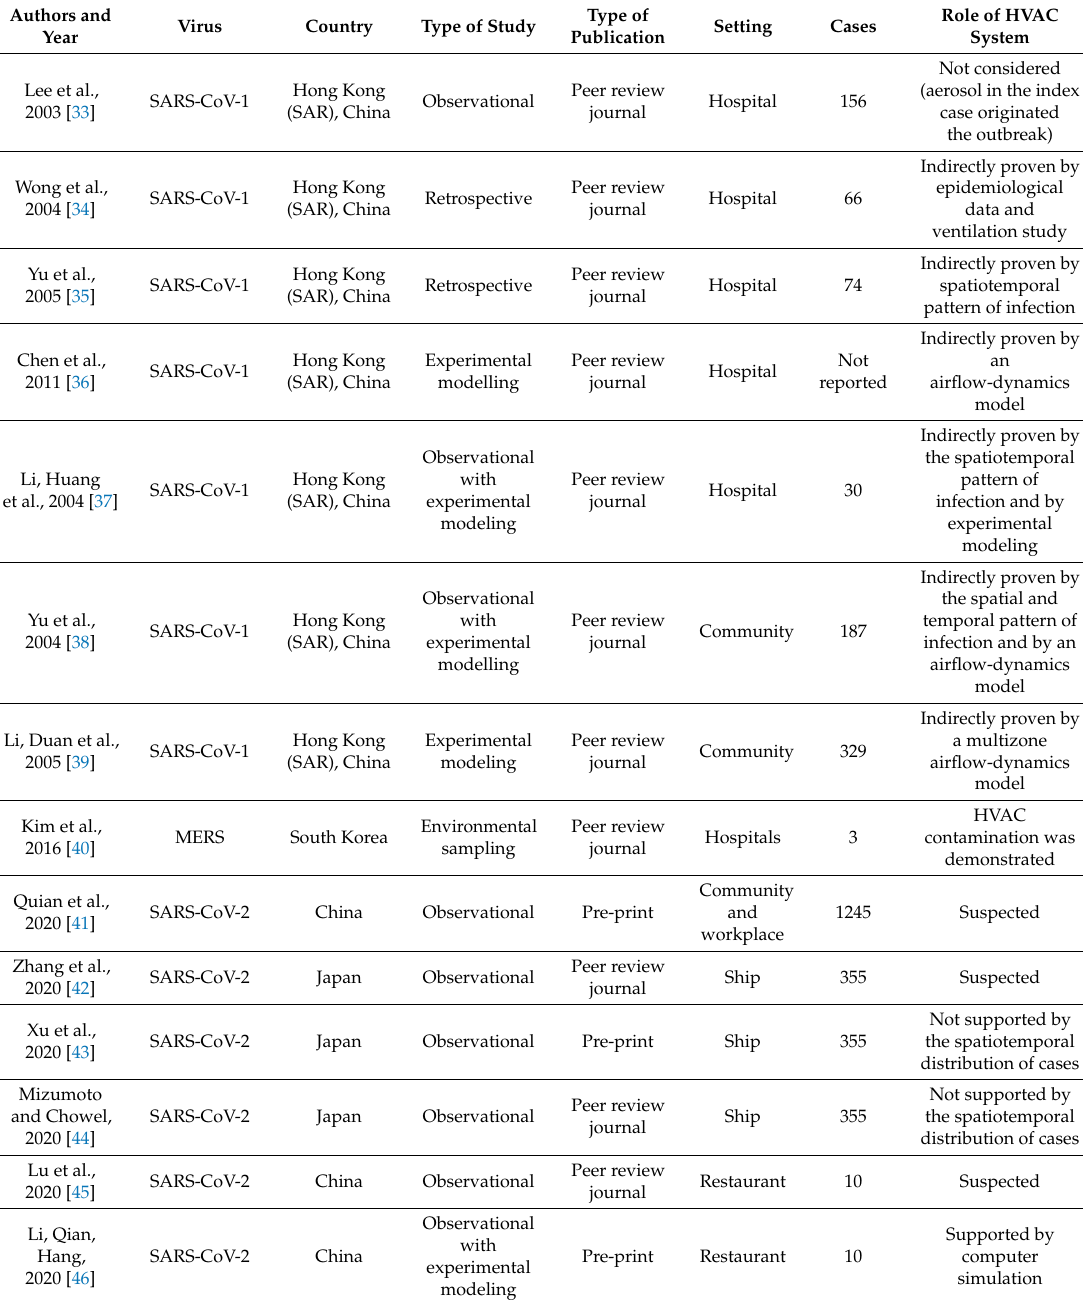
Table 1. Studies on coronavirus outbreaks in indoor